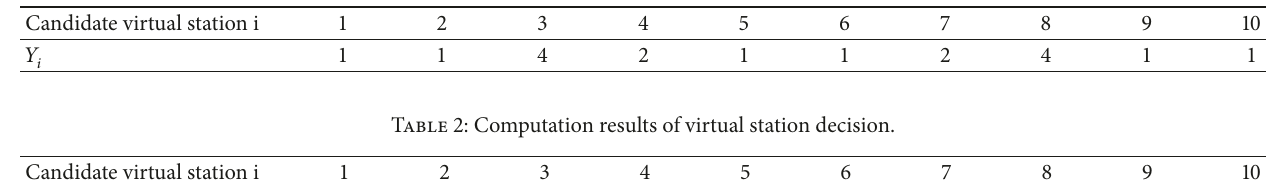
Table 1: Number of bikes in each virtual candidate station.